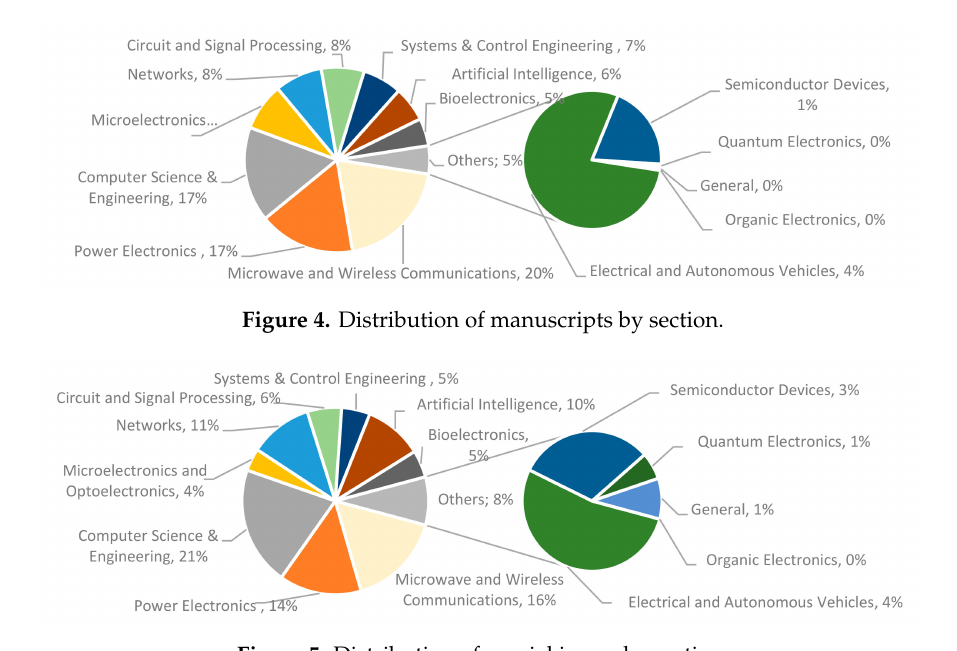
Figure 5. Distribution of special issues by